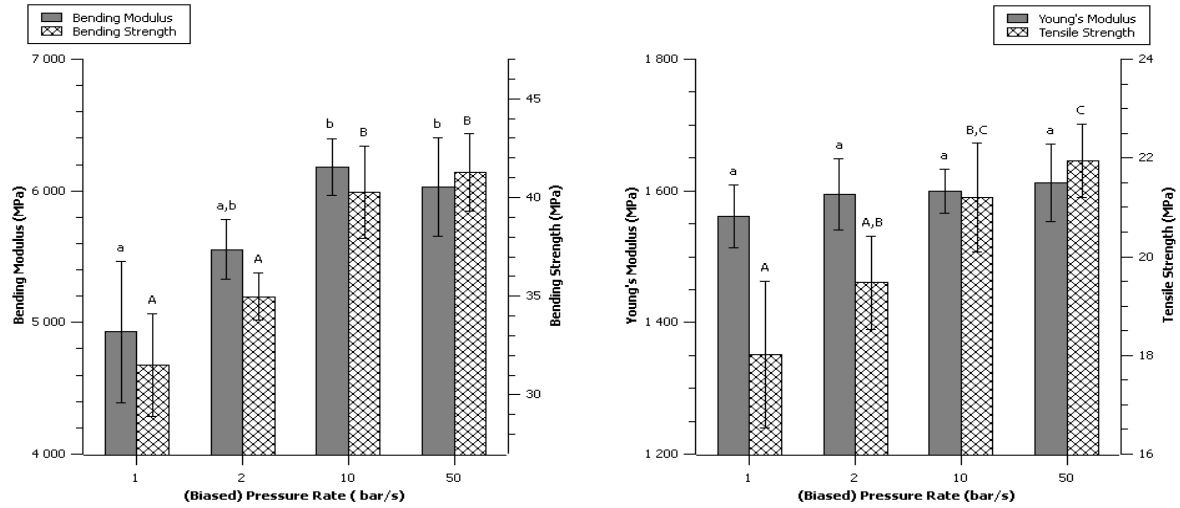
Figure 7. Effect of pressure establishment rate. Data are given as mean ± confident interval (95%). The letters on top of the column express significant difference of means according to Scheffé test with a 95% confident level. Small letters for moduli and capital letters for